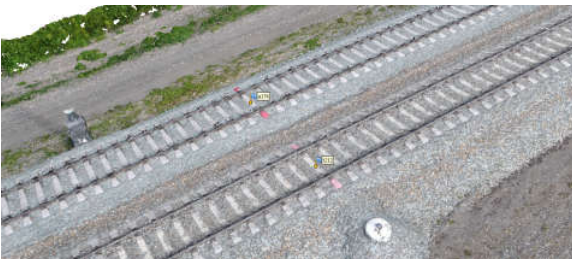
Figure 4. A fragment of a dense point cloud with control points placed by pairs